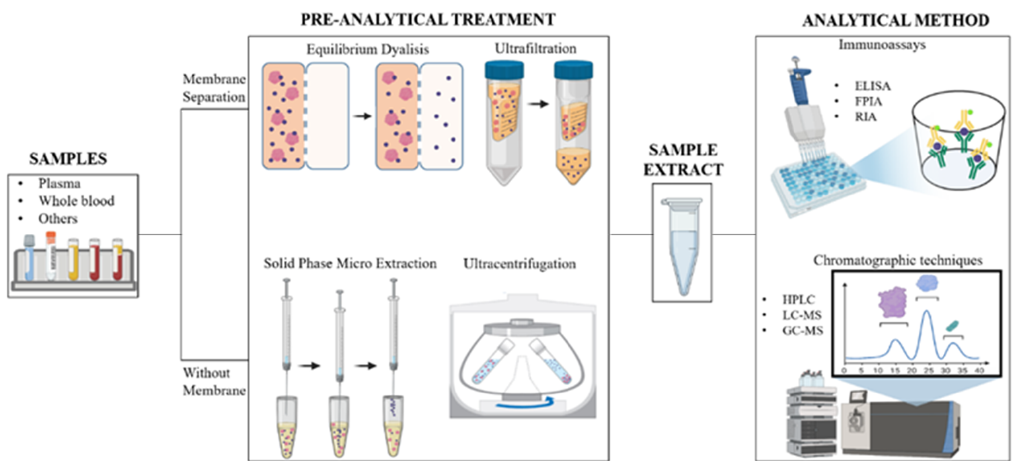
Figure 2. Schematic representation of the workflow carried out for the quantization of free and protein-bound drug in a biological matrix (Image created with BioRender.com).